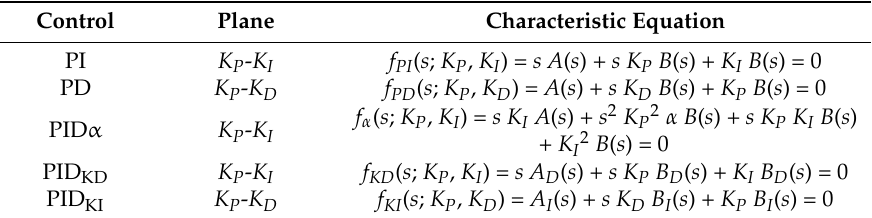
Table 1. Stability regions on the controller parameter